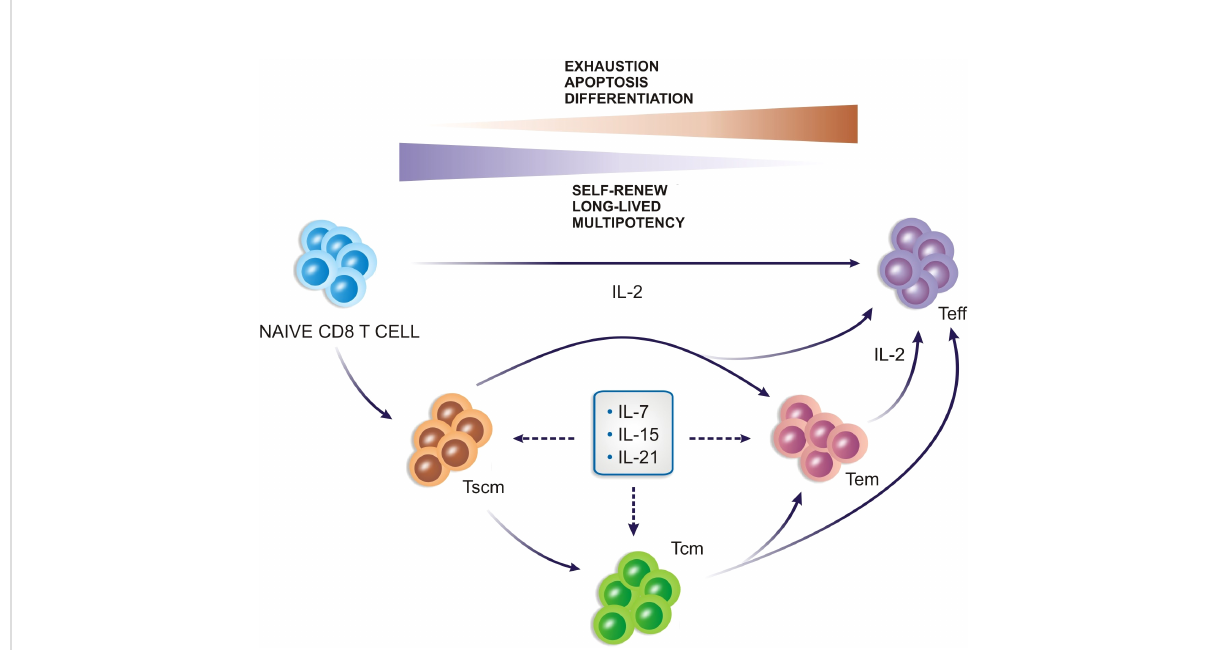
FIGURE 1 The cytokines dynamics in the tumor microenvironment and their role in the maintenance of the immunosuppressive phenotype. The microenvironment becomes hostile to the proliferation and effector functions of T cells and CAR-T